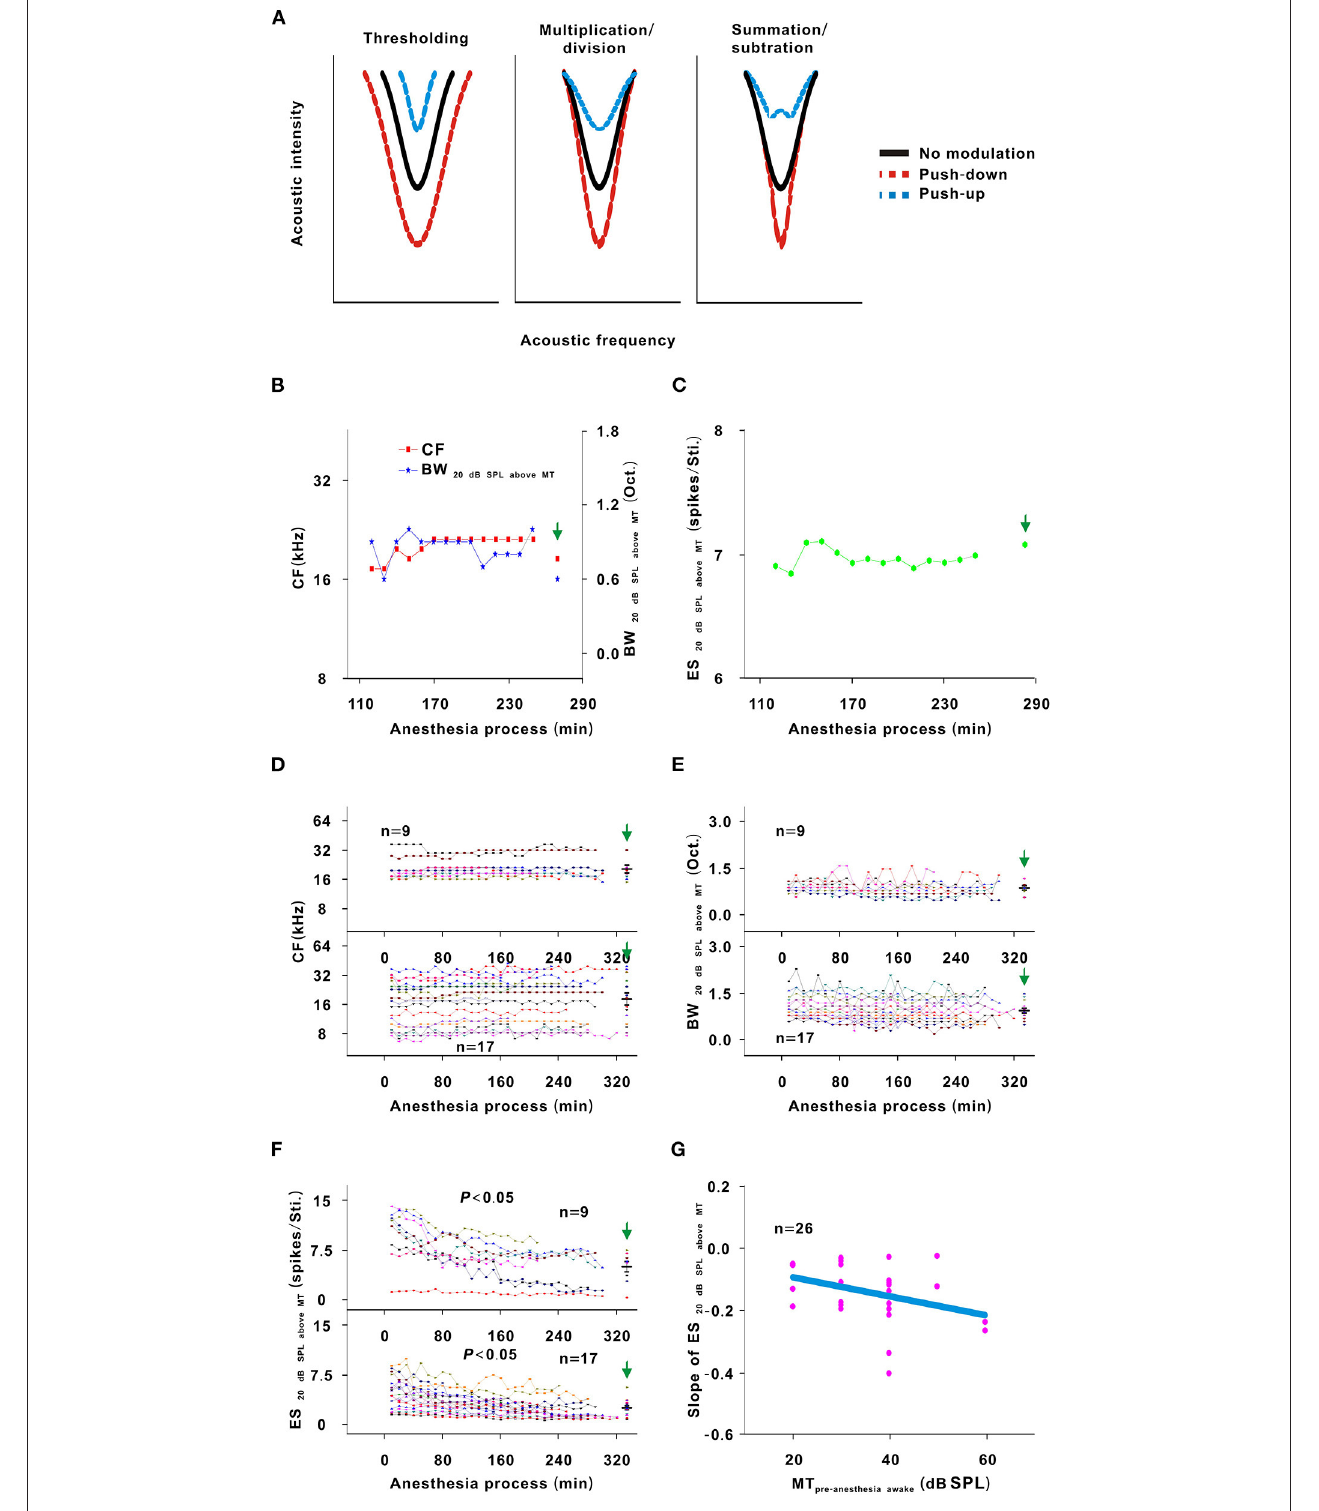
FIGURE 7 | Changes in the TRF of neurons. (A) Three potential models for TRF change. Each curve was the contour of the TRF. The left, middle and right sketch maps, respectively, indicated the thresholding, multiplication/division and summation/subtraction models. Black solid line indicated the contour of the TRF with no modulation. Red dotted line indicated the contour of the TRF with push-down. Blue dotted line indicated the contour of the TRF with push-up. (B) CF and above MT